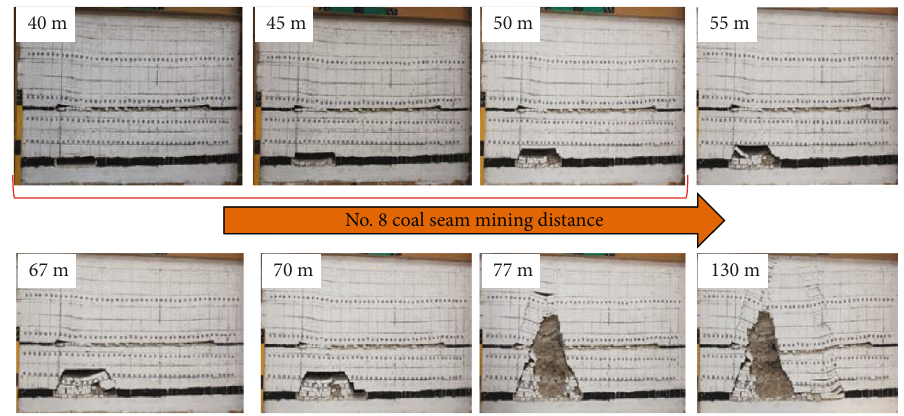
Figure 4: The law of model rock collapse during